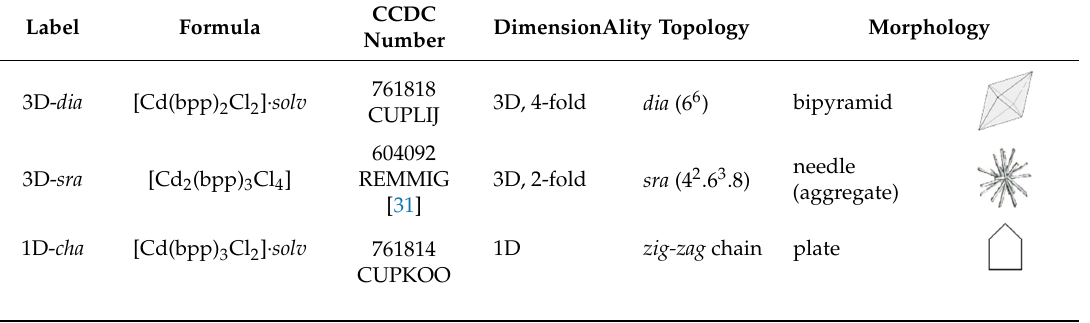
Table 1. Cd-bpp coordination networks studied in this work. See also [26,30,31].